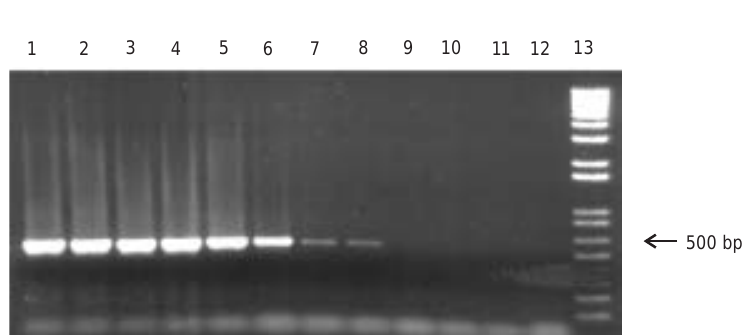
Figure 2. Agarose gel electrophoretic analysis of the PCR assay performed with MHRHF/MHRHR and dif- ferent concentrations of DNA/µL obtained by dilution from a culture of Mycoplasma hyorhinis . Lane 1 , 1000 ng; lane 2 , 100 ng; lane 3 , 10 ng; lane 4 , 1 ng; lane 5 , 100 pg; lane 6 , 10 pg; lane 7 , 1 pg; lane 8 , 100 fg; lane 9 , negative control (water); lane 10 , 10 fg; lane 11 , 1 fg; lane 12 , 100 atg; lane 13 , size markers DNA-1 kb plus (Invitrogen).